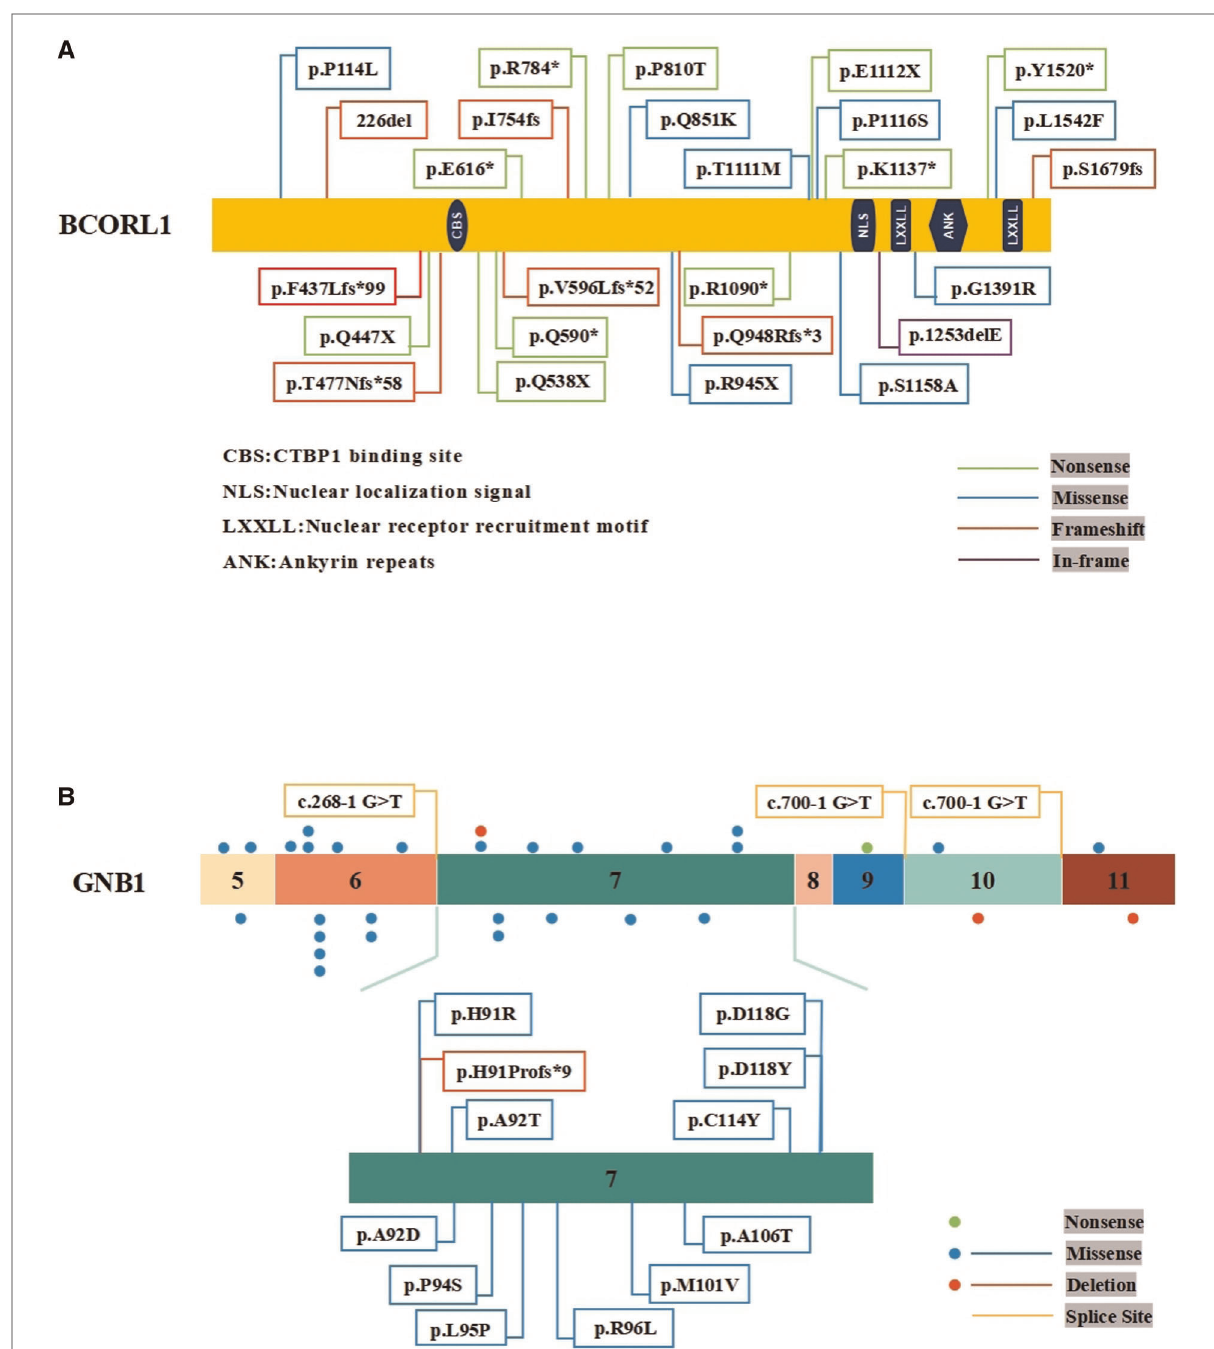
FIGURE 2 Schematic representation of BCORL1 and GNB1 mutations. ( A ) The mutations of BCORL1 in AML. ( B ) The mutations in Exon 7 of the GNB1